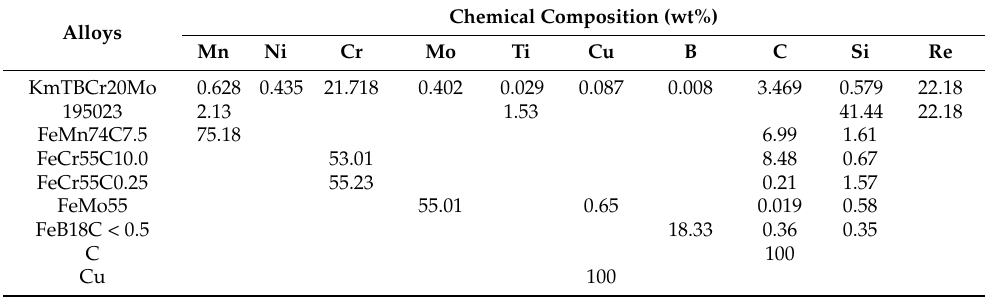
Table 2. Chemical composition of the materials.